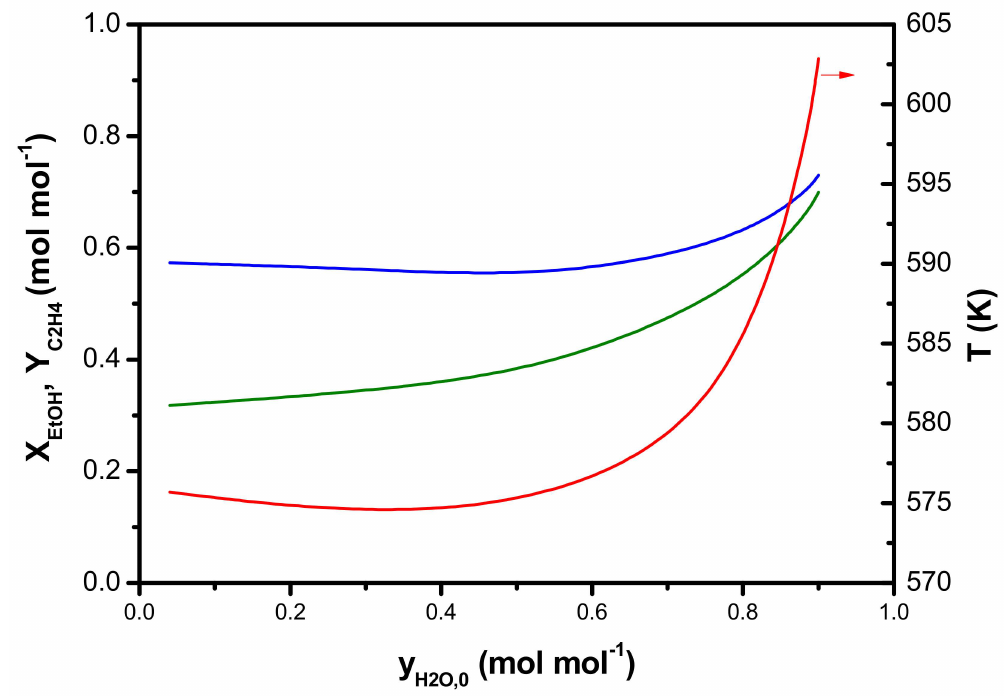
Figure 9. Ethanol conversion (X EtOH, blue), ethene yield (Y C2H4 , green), and temperature (T, red) as a function of water inlet content. Calculations were made by integration of Equations (5)–(7) and (12) and simultaneously solving Equations (26) and (28) with the corresponding net production rates as defined in Equation (27), with parameters taken from Table 2 and the experimental conditions given in Table